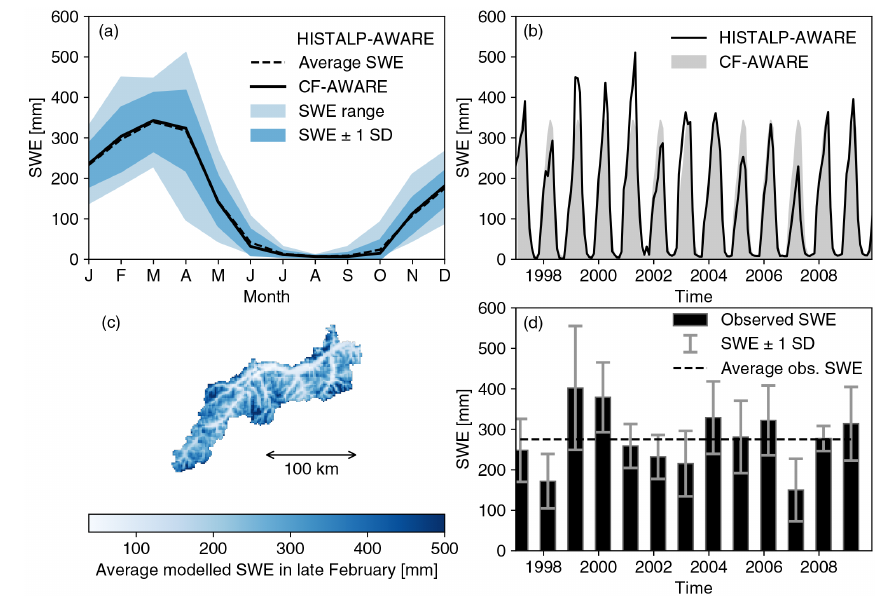
Figure 3. Observed and simulated snow states. (a) Range and standard deviation of SWE time series computed for single years and the corresponding mean monthly averages derived from AWARE using HISTALP data (HISTALP-AWARE). Average SWE conditions computed using climatological forecasts (CF-AWARE) are displayed as well. (b) This plot shows the same data but as time series between 1997 and 2009. (c) Map showing the average spatial SWE distribution computed for February. (d) SWE observations in February collected from stations in the study area above 1400ma.s.l. (Schöber et al., 2016). The error bars show the ± 1SD (standard deviation) of observations for each year (see Schöber et al., 2016, for further details on SWE